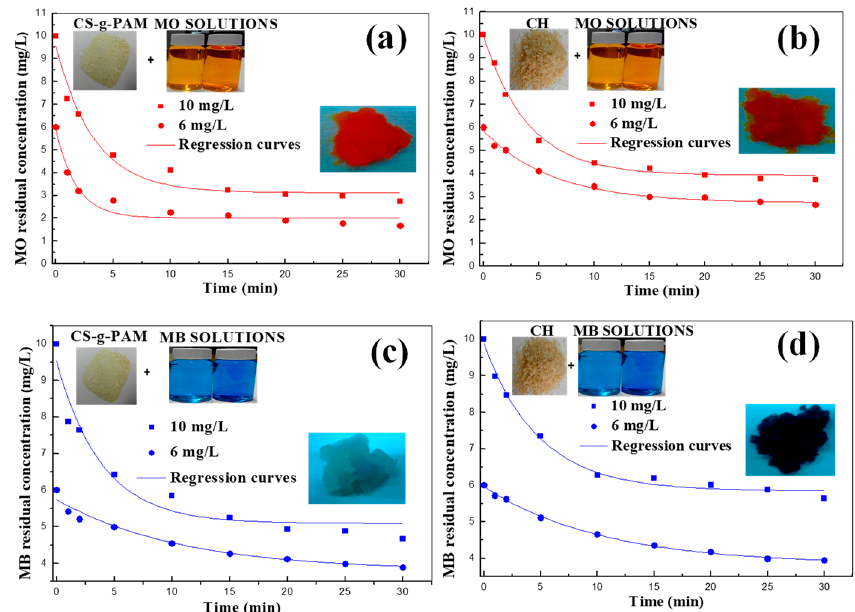
Figure 5. Effect of the initial dye concentration on decolorization efficiency: ( a ) MO on CS-g-PAM, ( b ) MO on CH, ( c ) MB on CS-g-PAM and ( d ) MB on CH (concentration: 0.3 g · 100 mL − 1 ; initial pH: 8.0 for MB and 5.0 for MO; 25 °C). Table 1. Results of nonlinear regression of the experimental data of the decolorization of MB and MO by chitin and